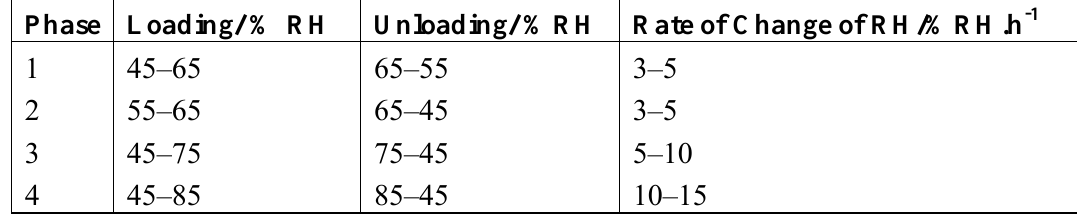
Table 2 Experimental RH loading and unloading sequence scheme.